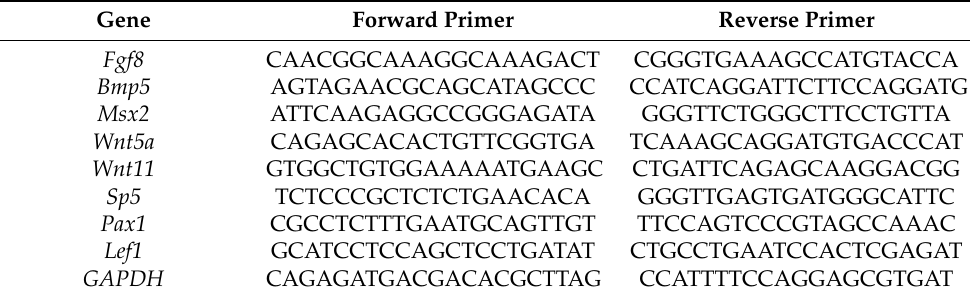
Table 1. Primer sequences that were used in the present